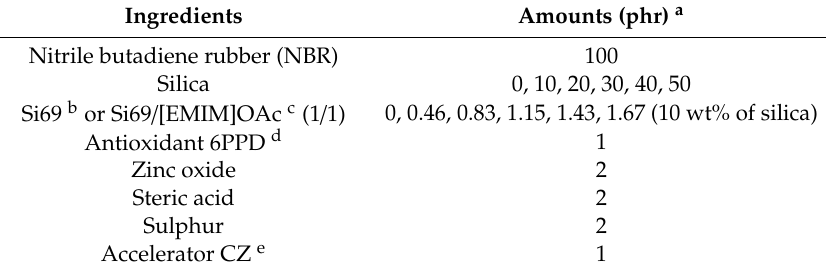
Table 1. Compositions of the nanocomposites.